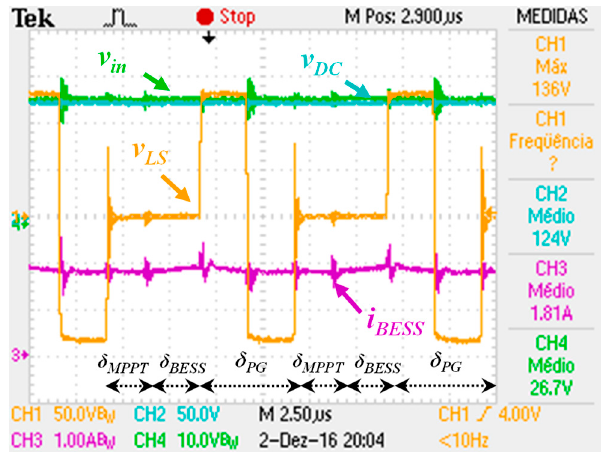
Figure 17. Experimental results of the DC–DC power converter: v DC , v in , v LS and i L 1 with the MPPT and the BESS control algorithms enabled.